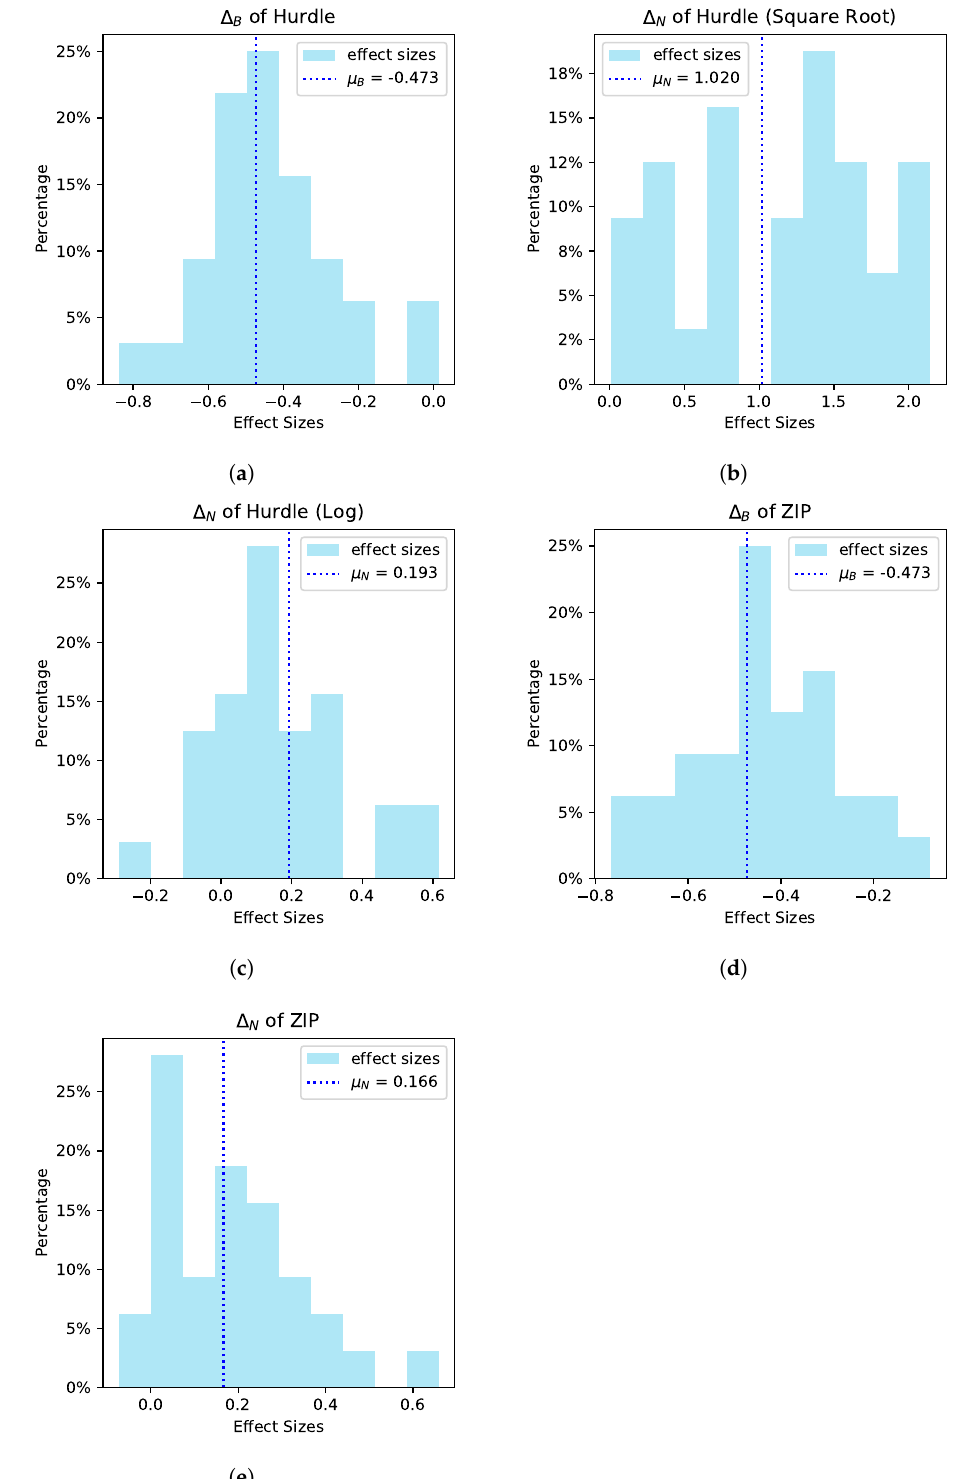
Figure A1. Effect sizes ∆ i , B ’s, ∆ i , N ’s, µ B , µ N for each base model class. The effect sizes are used to generate rewards under action A = 1 for the simulation environment. ( a ) Bernoulli component (hurdle); ( b ) Nonzero component (square root); ( c ) Nonzero component (log); ( d ) Bernoulli component (ZIP); ( e ) Poisson component